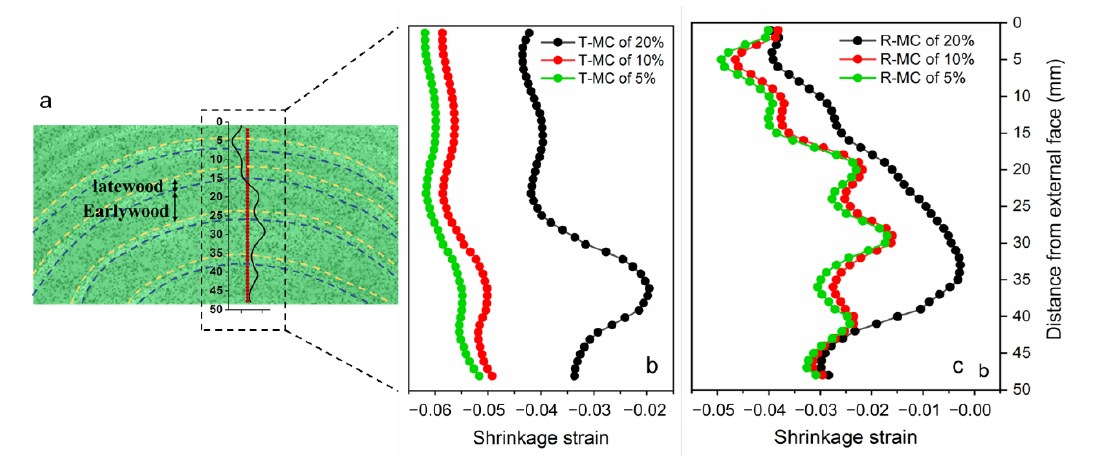
Figure 4. ( a ) Tangential shrinkage strain distribution diagram at initial state and the growth rings are distinguished by yellow and blue dashed lines. The dashed part shows the selection of the test points and the variation shrinkage strains with distance. The variation of tangential ( b ) and radial ( c ) shrinkage strains from the external to the internal face at different MC values.